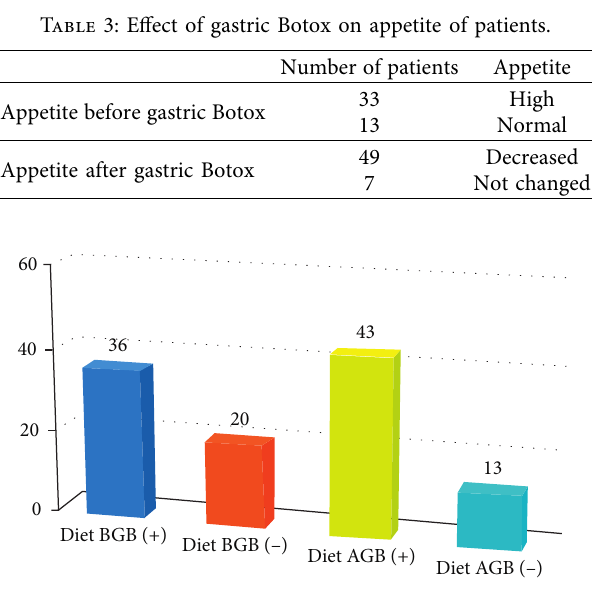
Figure 1: Dietary practice before gastric Botox (BGB) and after gastric Botox (AGB).